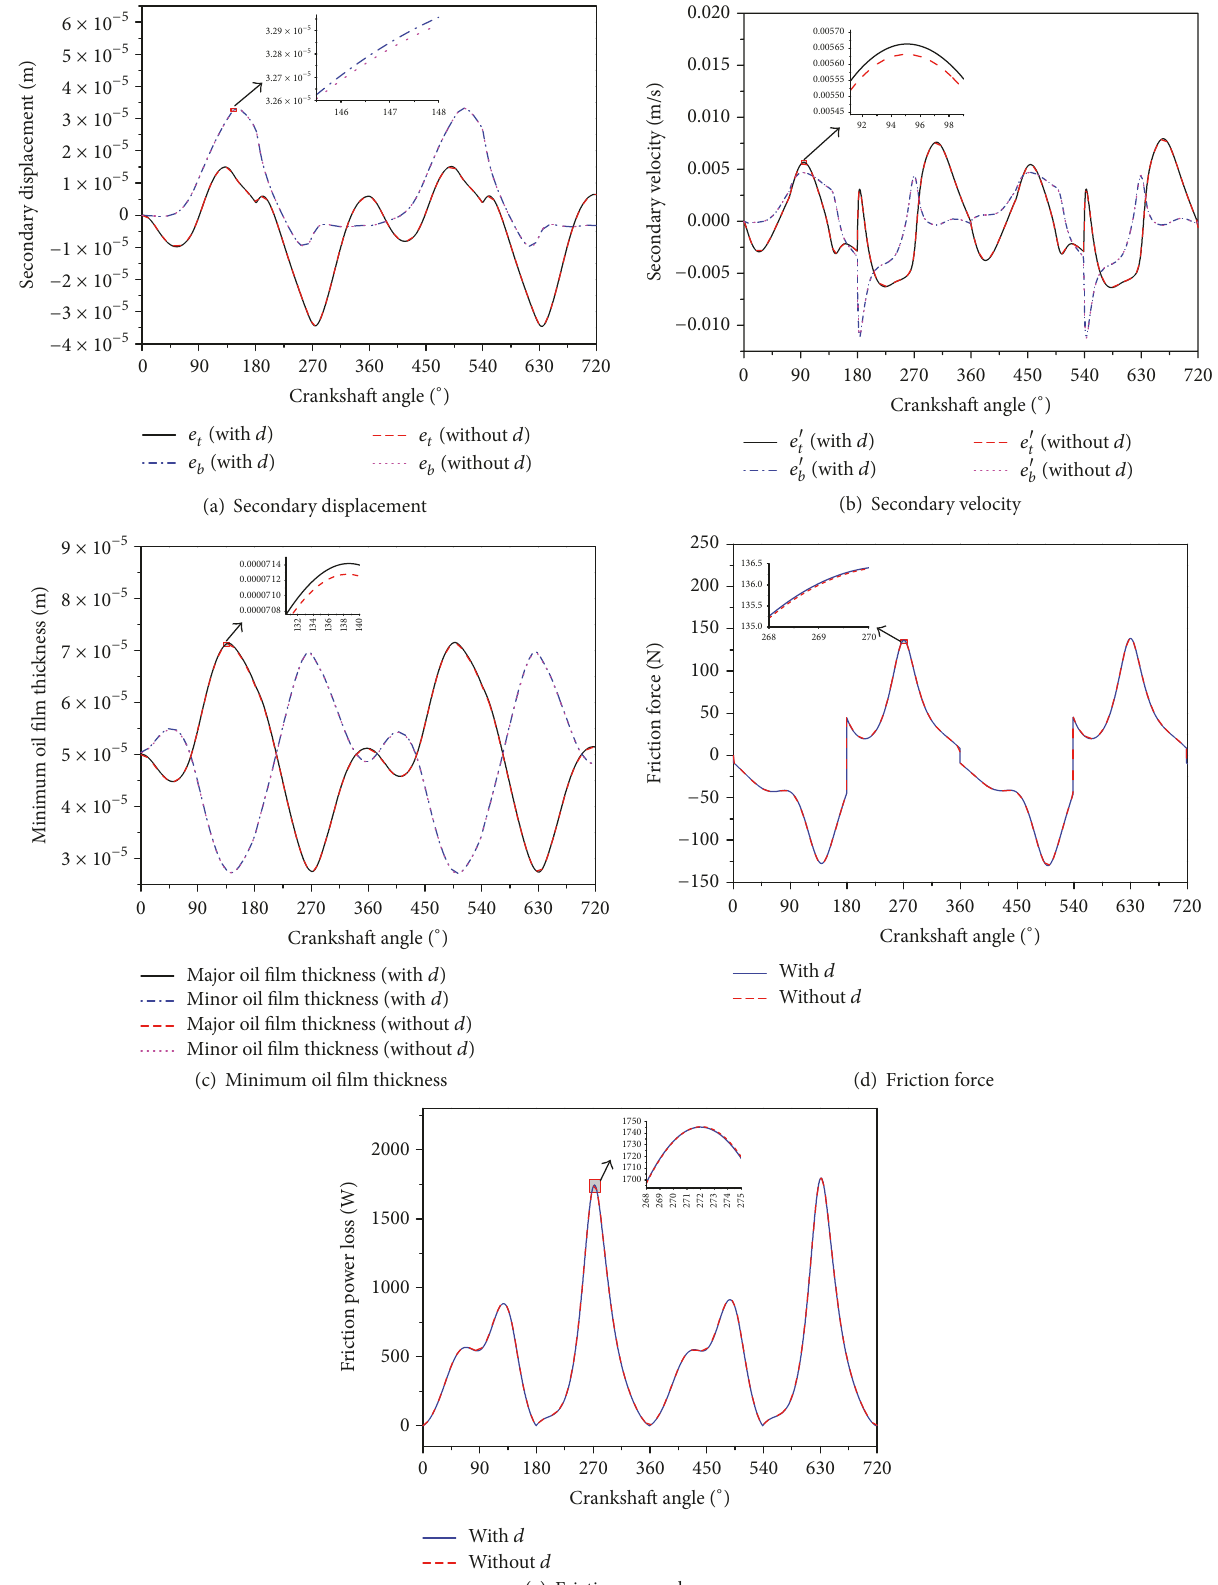
Figure 8: Comparison of secondary motions of the piston with and without elastic